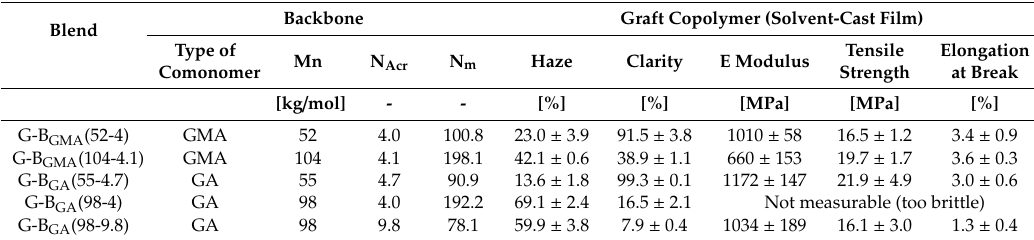
Table 5. Mechanical and optical properties of the